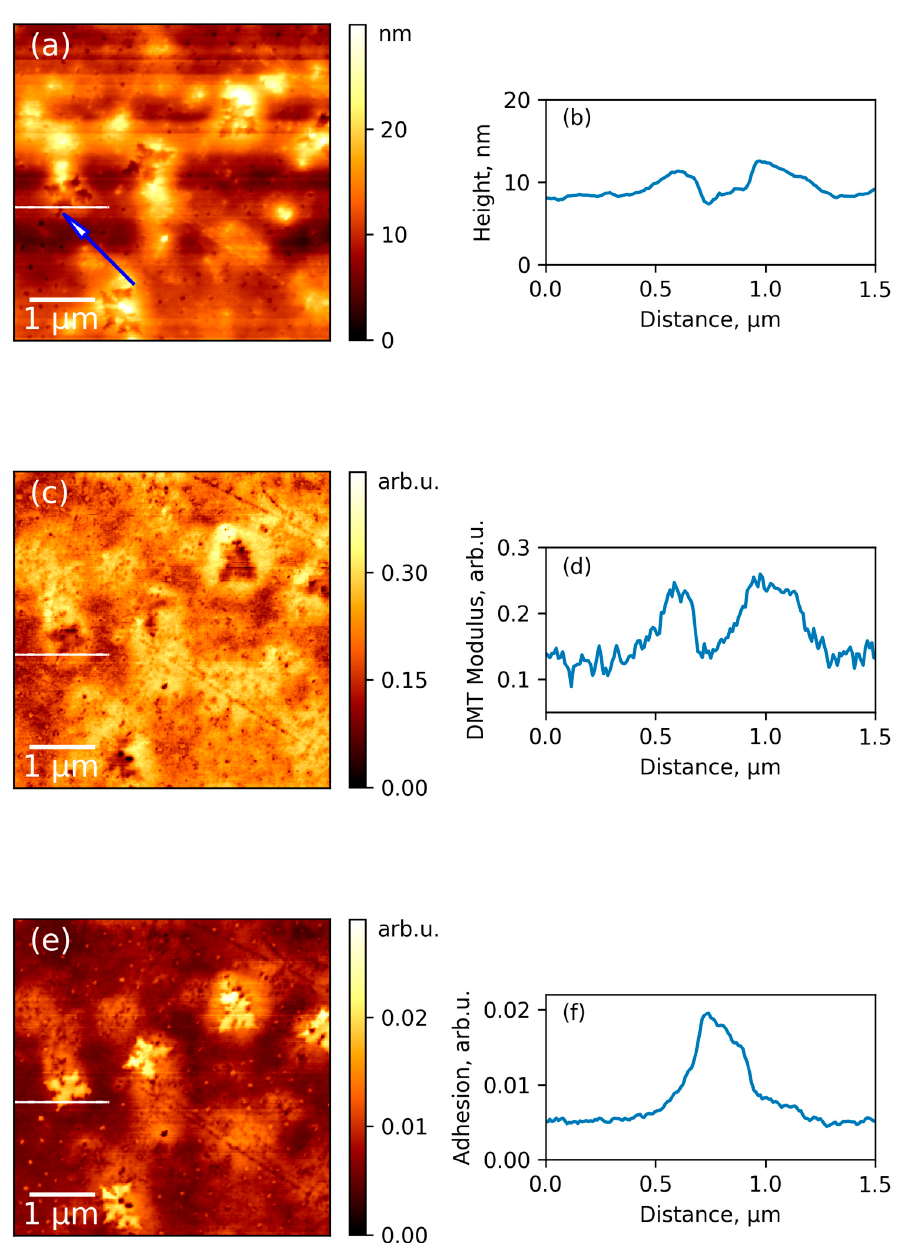
Figure 7. Surface topography of bottom side of composite ( a ), map of elastic modulus ( c ), and map of adhesion ( e ); ( b , d , f ) show profiles for these corresponding channels taken at the selected region of the surface with an imprint from zirconia nanoparticle (shown with white line segment).